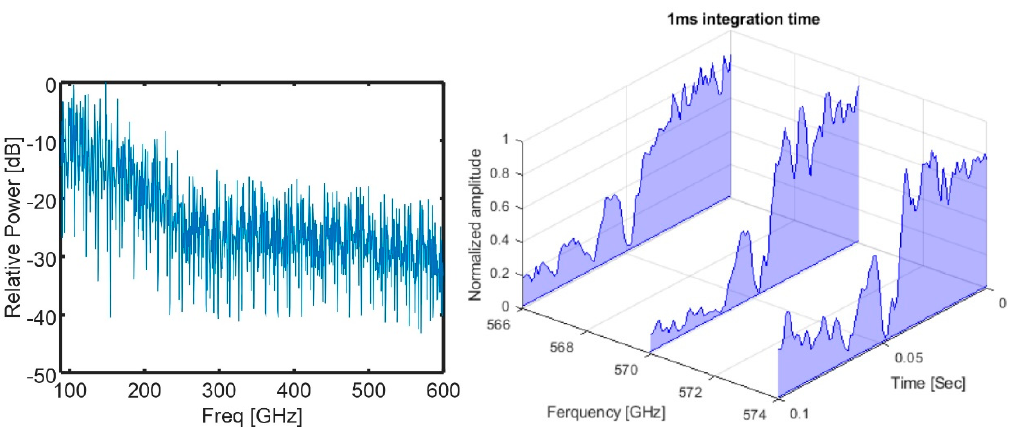
4 of 14 Figure 1. ( Up ) System Architecture of a benchtop THz Dual-Comb Spectrometer (TDCS). In the “comb source stage” we generate an optical comb using a DML and two cascaded phase modulators (PMs) operated with a signal generator. The PS is used to widen the optical comb produced for the first PM. The output of this stage is divided for an optical coupler and both signals enter the “comb line selection stage” where two optical circulators are used with distributed feedback (DFB) lasers to produce the OIL phenomenon. The output of the upper branch of the stage passes through the “frequency shift stage” where AOMs are used to shift the incoming signal frequency. Next, the signal